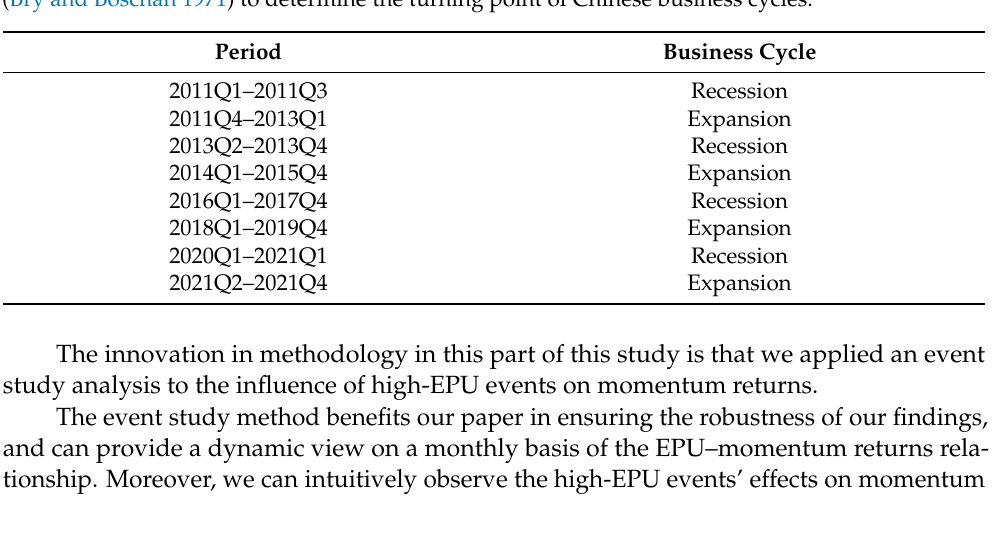
Table 2. Business cycles in the Chinese economy. We follow the method used by Li et al. (2021) (Data from the Wind Database). We adopt seasonal adjustments to real GDP data of China from 2011 to 2021 through the X-12 procedure and use the HP filter (Hodrick and Prescott 1997) to extract the cyclical element of the Chinese GDP series. Then we apply the Bry–Boschan algorithm (Bry and Boschan 1971) to determine the turning point of Chinese business